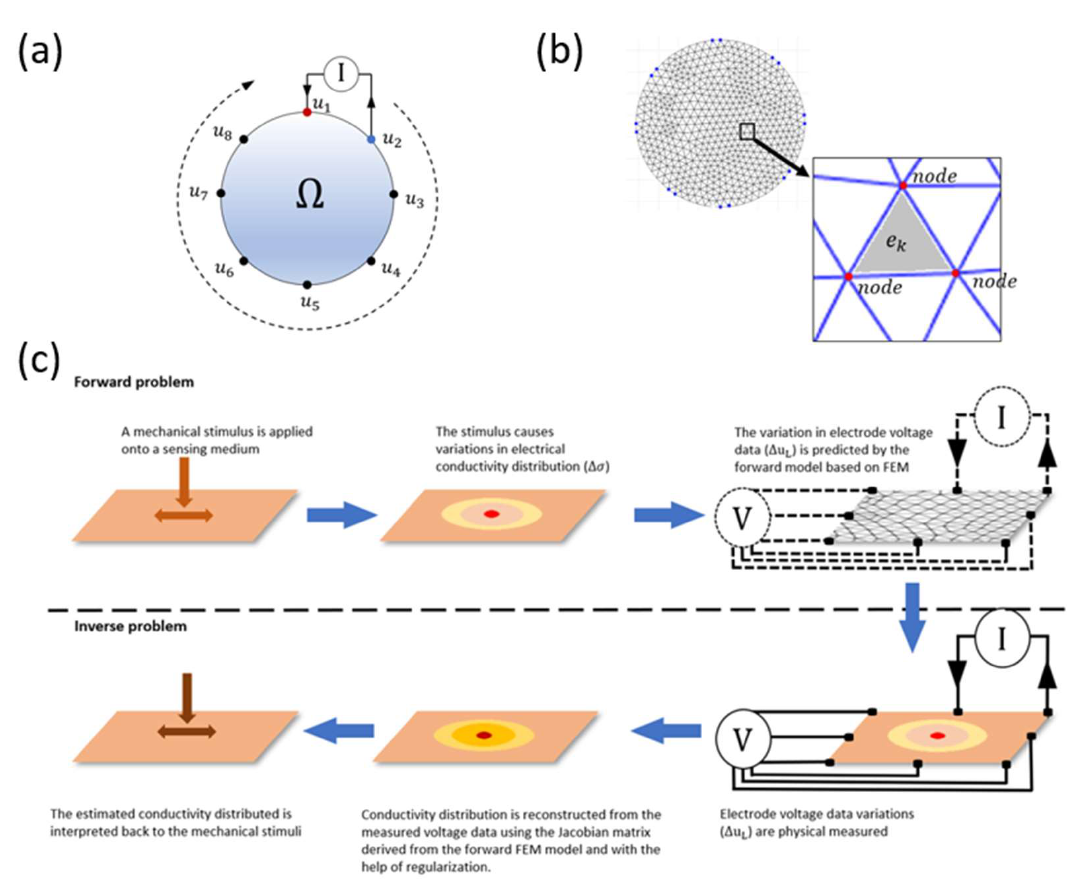
Figure 1. The working mechanism of EIT-based touch sensors. ( a ) The basic working principle of EIT: voltage measurements are taken at every electrode for each current injection. ( b ) Discretizing the domain of the sensing material into a collection of a finite number of elements and nodes using the finite element method. ( c ) The forward problem and the inverse problem.